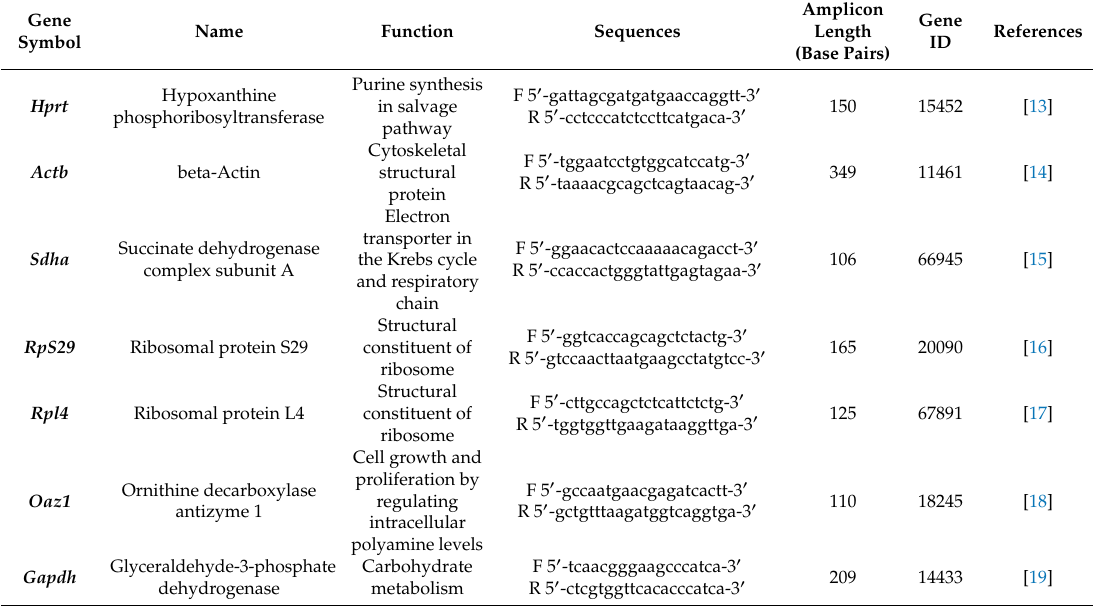
Table 1. Primer sequences of housekeeping genes used in